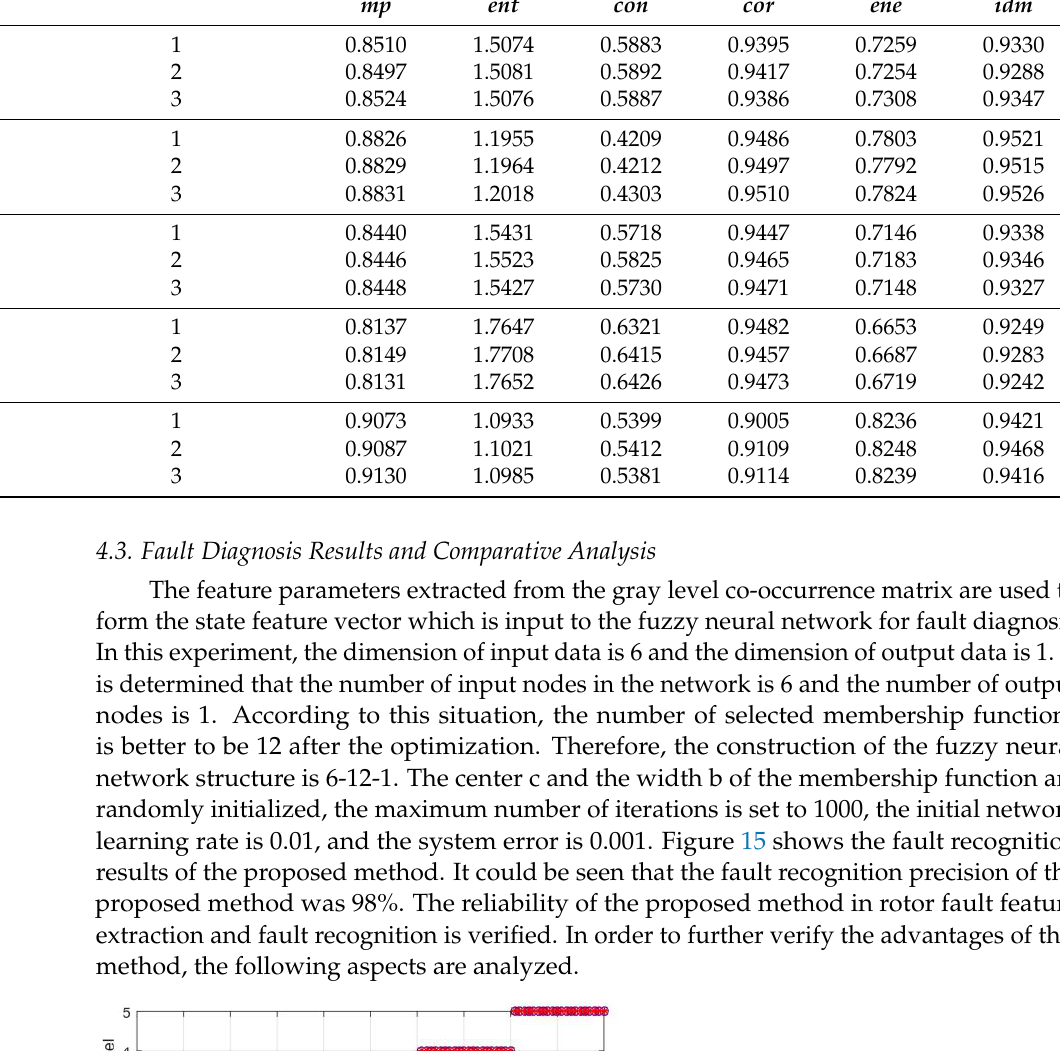
Table 6. Characteristic parameters of the rotor under different states.